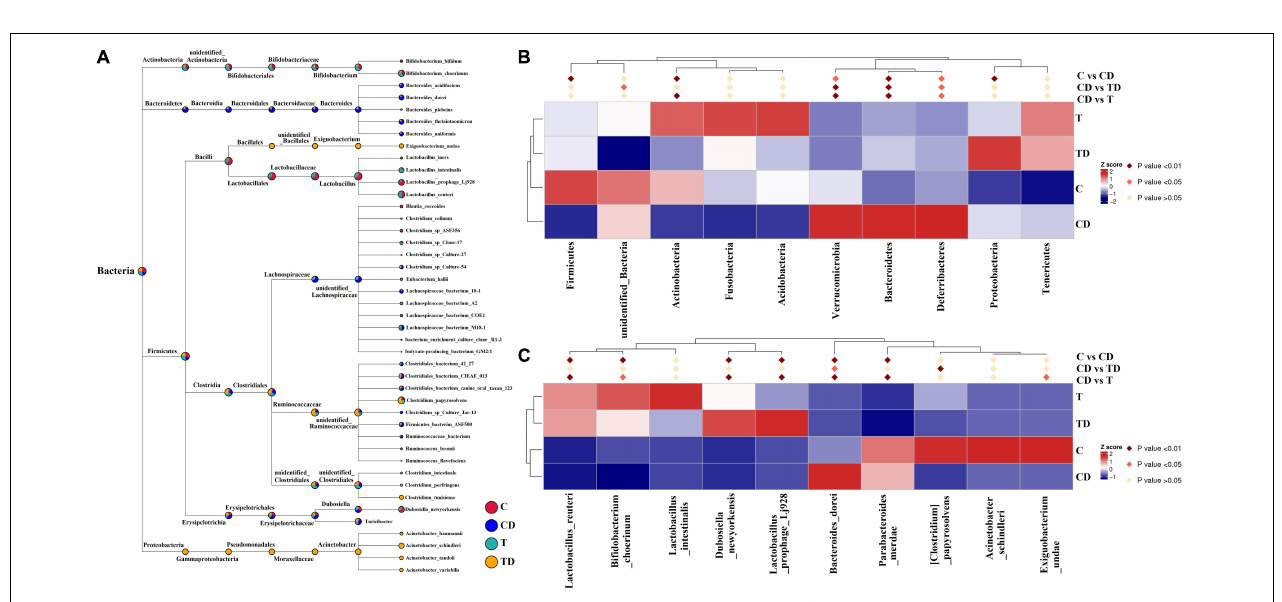
FIGURE 4 | Comparison of the microbial communities in mice. (A) Evolutionary tree of the top 100 genera. (B) Microbial taxa differentially distributed between groups at the phylum level. (C) Identification at the species level by MetaStat analysis.